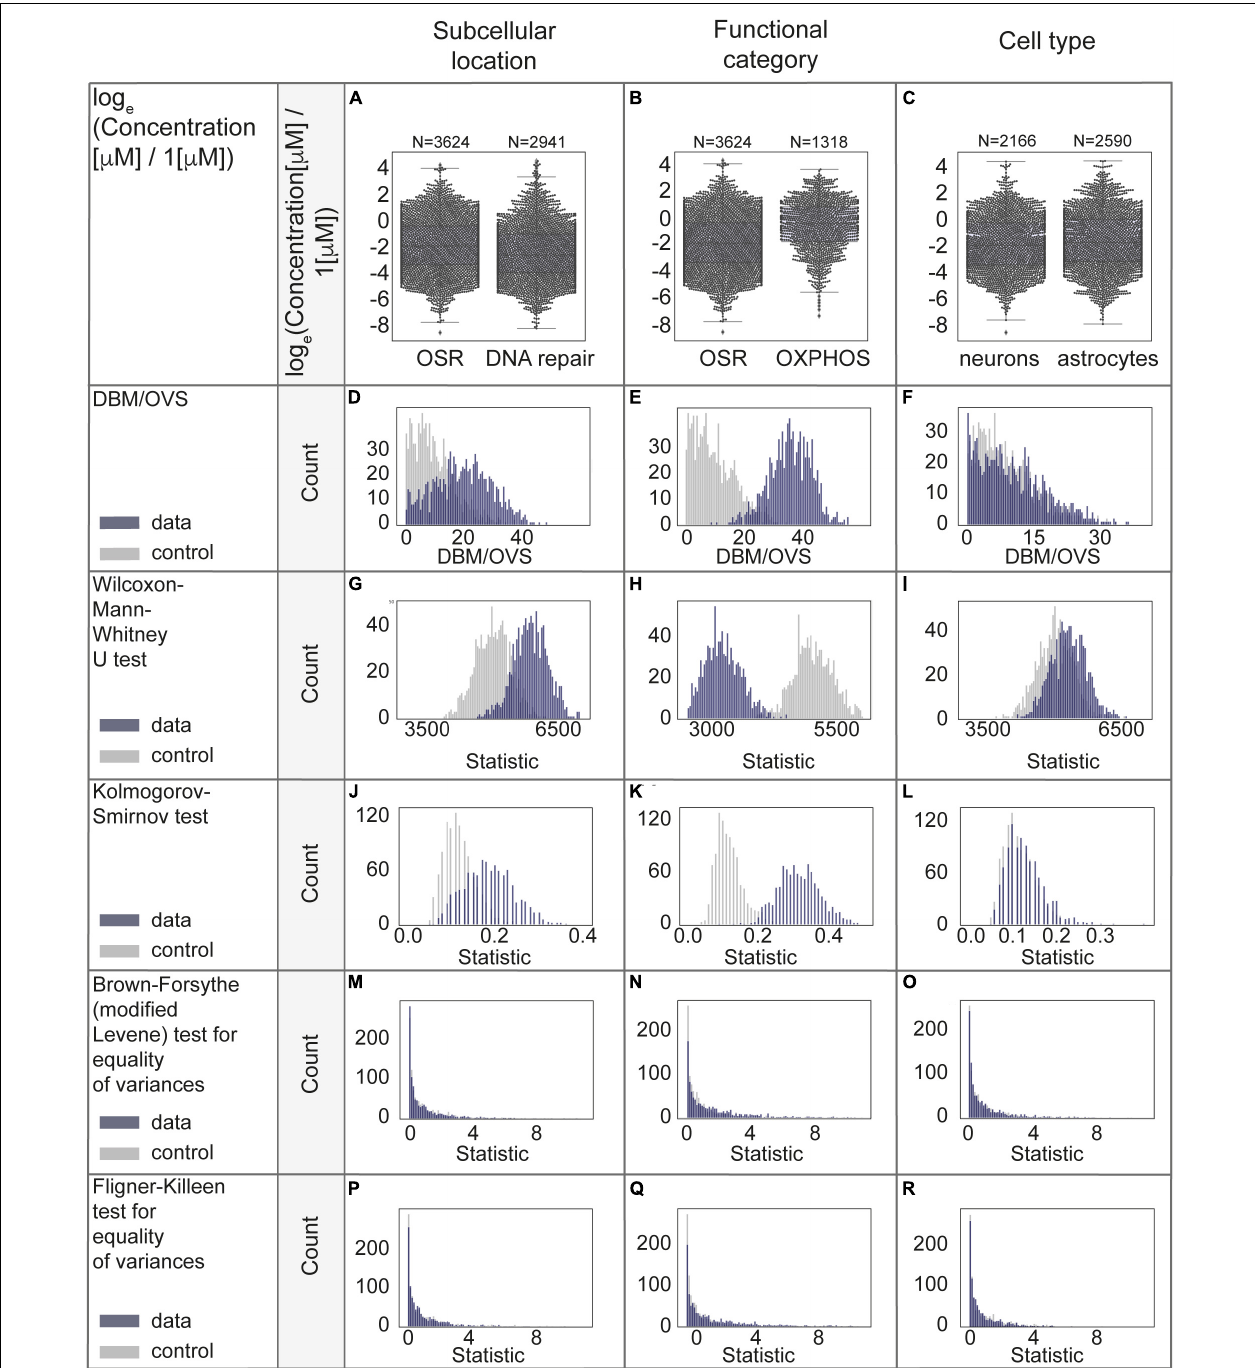
FIGURE 5 | Statistical evaluation of factors with a potential to explain biological variability of protein concentrations. (A–C) Comparison of protein concentrations in different groups of proteins. Boxplots characteristics: (A) OSR (oxidative stress response): center line, median: − 1.86; upper and lower quartiles: Q1: − 3.31, Q3: − 0.32; whiskers, 1.5x interquartile range: − 7.77, 4.14; outliers: − 8.57, 4.39, 4.18. DNA repair: center line, median: − 2.56; upper and lower quartiles: Q1: − 3.92, Q3: − 0.95; whiskers, 1.5x interquartile range: − 8.24, 3.48; outliers: 3.74, 3.36, 3.76, 3.58, 3.62, 4.40, 4.57, 4.30, 3.71, 4.36, 3.94, 3.87, 4.45, 4.70, 4.15. (B) OSR (oxidative stress response): center line, median: − 1.86; upper and lower quartiles: Q1: − 3.31, Q3: − 0.32; whiskers, 1.5x interquartile range: − 7.77, 4.14; outliers: − 8.57, 4.39, 4.18. OXPHOS (oxidative phosphorylation): center line, median: − 0.35; upper and lower quartiles: Q1: − 1.74, Q3: 0.90; whiskers, 1.5x interquartile range: − 5.56, 3.72; outliers: − 7.34, − 5.87, − 6.35, − 6.15, − 6.59, − 6.87. (C) Neurons: center line, median: − 1.96; upper and lower quartiles: Q1: − 3.44, Q3: − 0.26; whiskers, 1.5x interquartile range: − 7.63, 4.39; outliers: − 8.57. Astrocytes: center line, median: − 1.74; upper and lower quartiles: Q1: − 3.17, Q3: 0.00; whiskers, 1.5x interquartile range: − 7.93, 4.43; no outliers. (D–R) Statistical analyses in permutations with multiple (1000) resampling with the sample sizes of 100. Types of analyses are named in the left panel of each